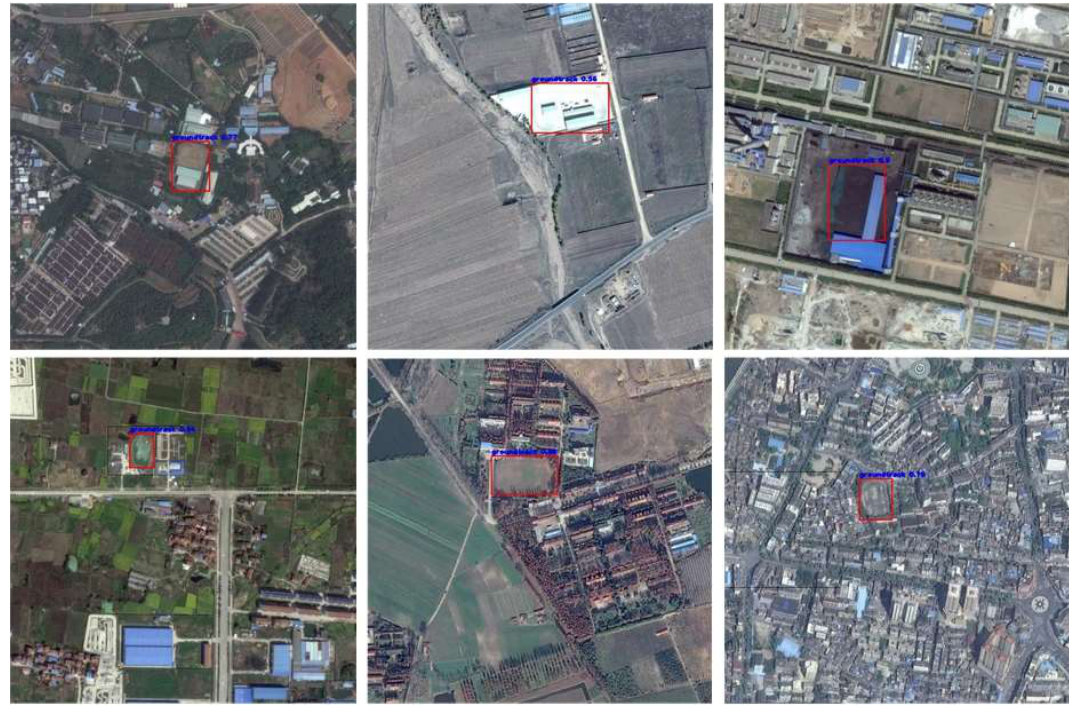
Figure 14. Detection examples of false positive errors.